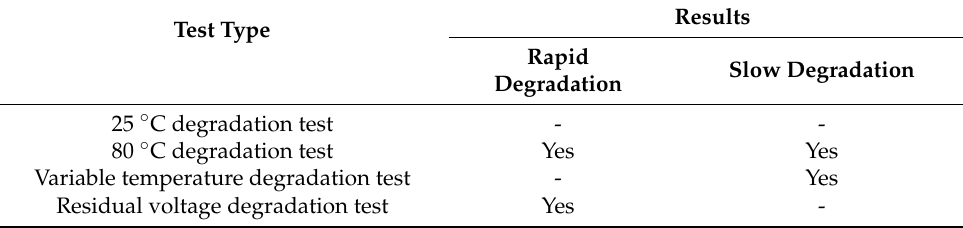
Table 6. Results of degradation tests.